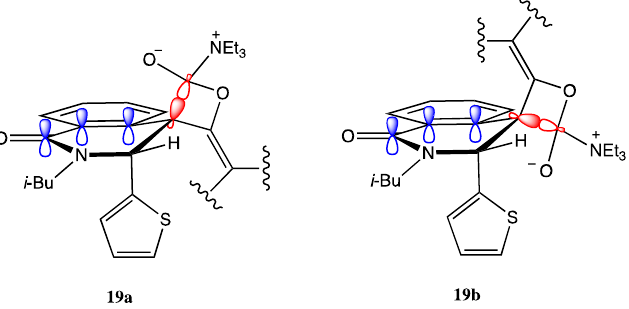
Figure 3. Orbital overlaps in the beta lactone—triethylamine adducts.